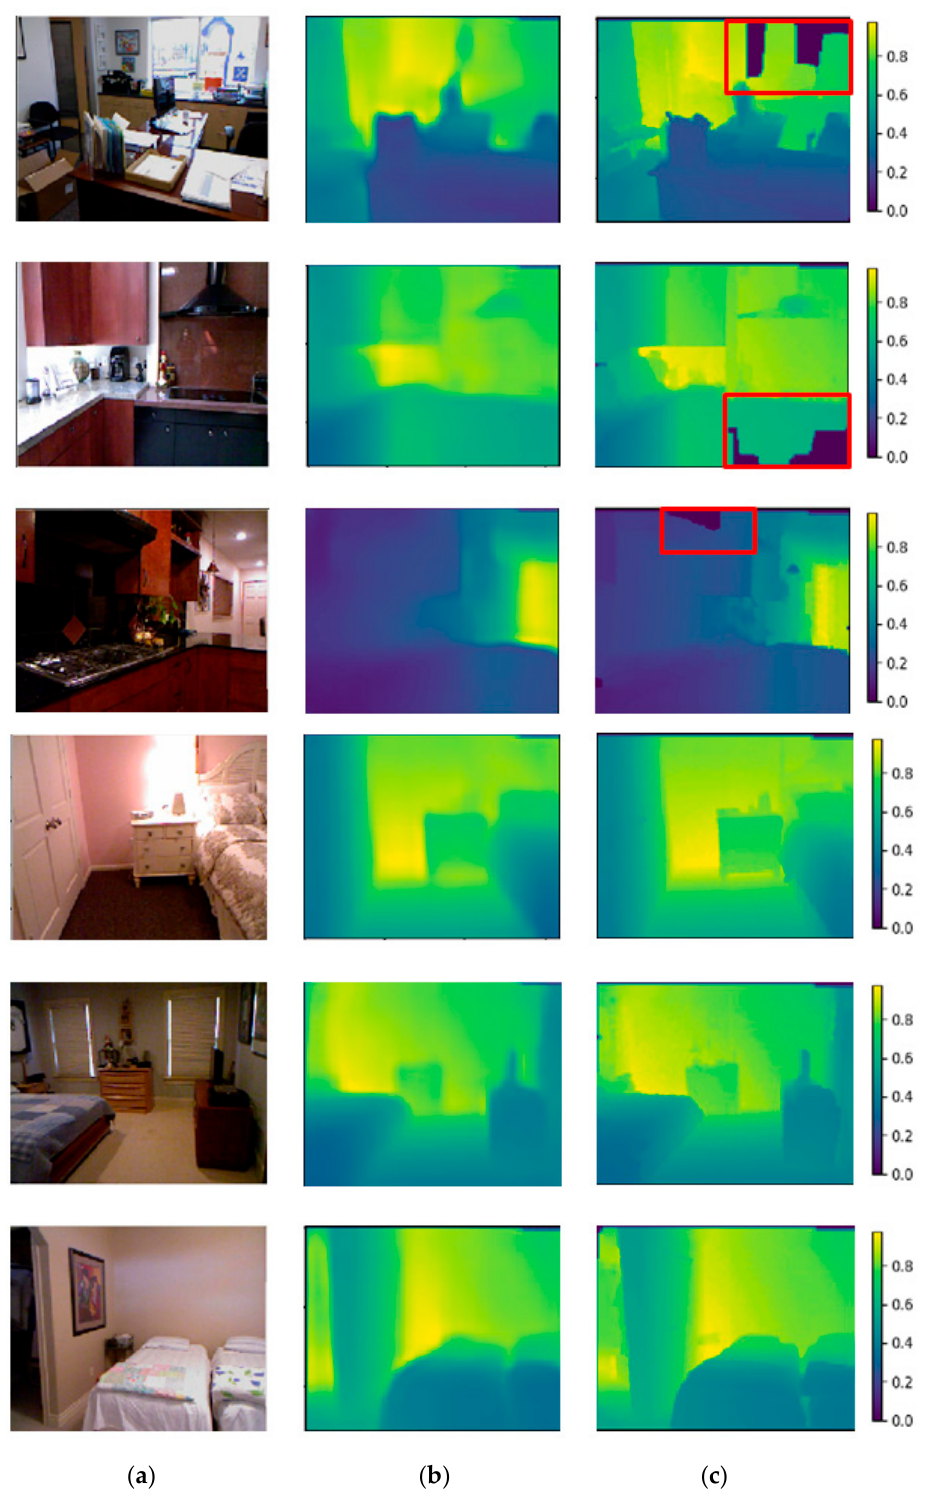
Figure 3. Example predictions from our algorithm. For each image we show ( a ) the input RGB image, ( b ) the prediction by our network, ( c ) the ground truth. The red border marks the area in the raw depth map where the depth map is missed. At the far right, the value of the scale labels from small to large represents the depth of the image ( a ) from near to far.